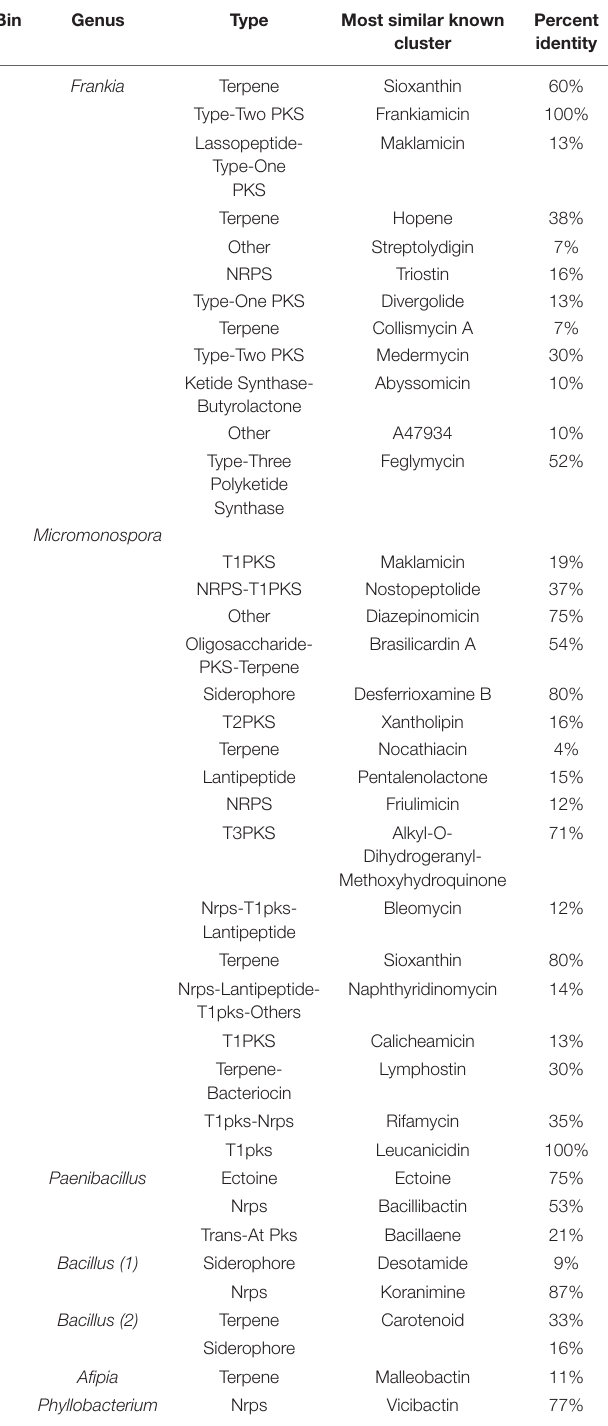
TABLE 2 | Secondary metabolite biosynthetic gene clusters identified each genome bin by antiSMASH.